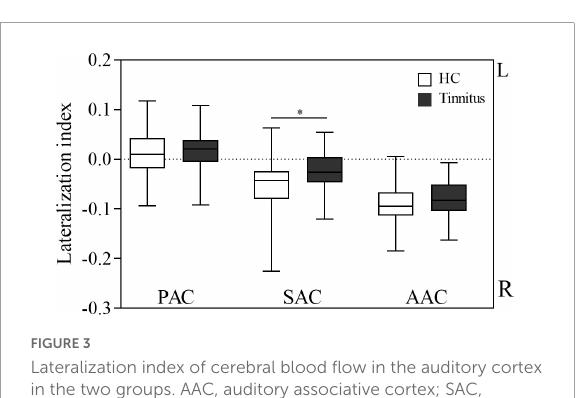
FIGURE3 Lateralization index of cerebral blood flow in the auditory cortex in the two groups. AAC, auditory associative cortex; SAC, secondary auditory cortex; PAC, primary auditory cortex; HC, healthy control; R, right; L, left. ∗ Statistical significance.